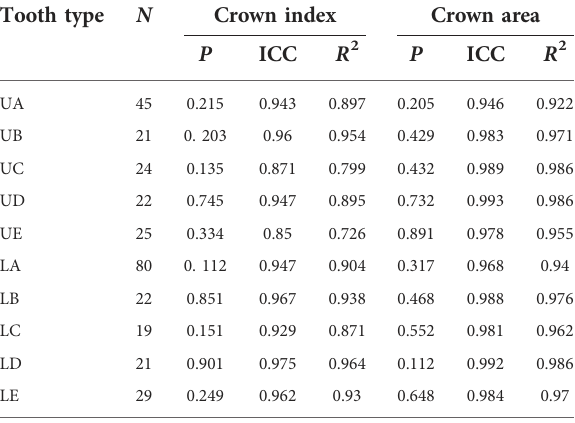
TABLE 2 Results of paired t -test, consistency analysis, and regression analysis for crown index and crown area of 308 extracted primary teeth by manual and digital